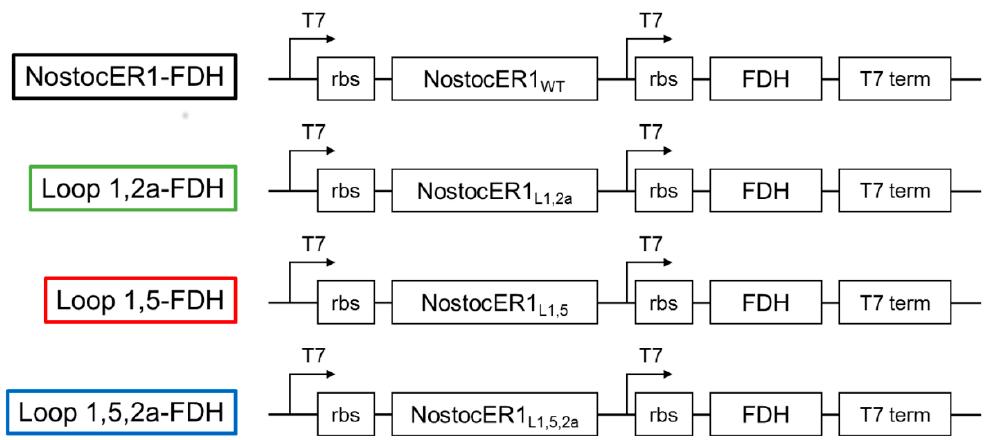
Figure 1. Modified pET28a( + ) vector constructs for the co-expression of the respective NostocER1 variants and FDH genes. Indicated are the expression cassettes, including the locations of the T7 promotors (T7), ribosome binding sites (rbs), the genes (NostocER1 and FDH), and the T7 terminators (t7 term).